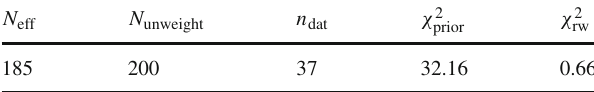
Table6 Thenumberofeffective N eff andunweighted N unweight replicas associated to the inclusion of the LHCb R pPb data on the nNNPDF3.0 prior fit via reweighting, together with the number of data points and the values of the χ 2 for this dataset before and after